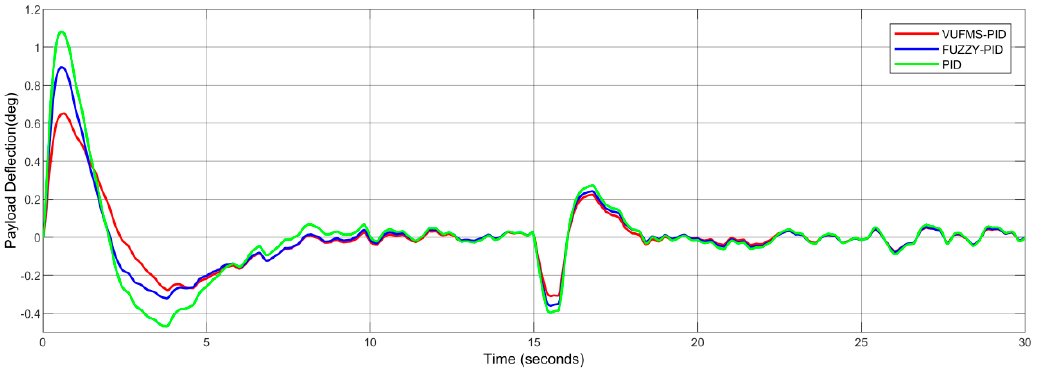
Figure 16. Payload’s swing angle using VUFMS-PID, FUZZY-PID and PID controller under working condition 1 with a crosswind and white noise.